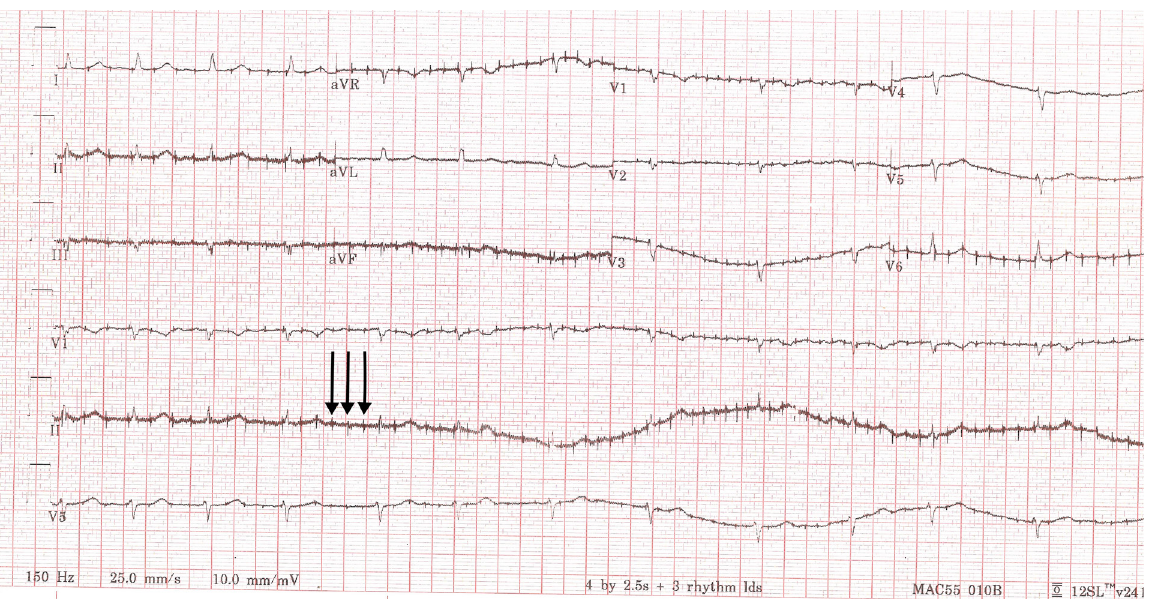
Image 1. 12-lead electrocardiogram demonstrates an irregular rhythm without p-wave morphologies and heart rate of 75, suggestive of rate- controlled atrial fibrillation. In addition, atypical, high-frequency electrical discharges (arrows) are seen irrespective of ventricular depolarization suggestive of aberrant pacemaker